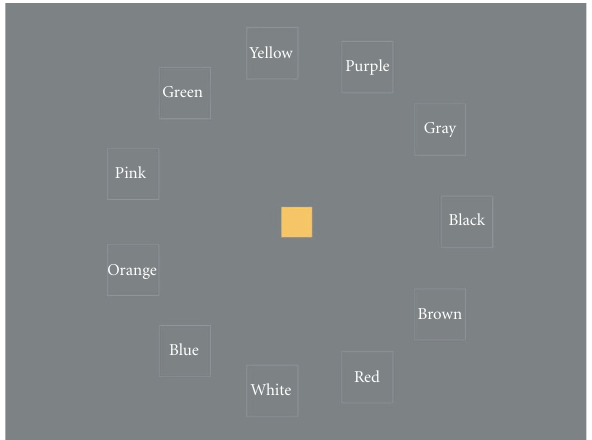
Figure 4: Stimulus example. The test color is pasted at the center of the image, on a gray background.